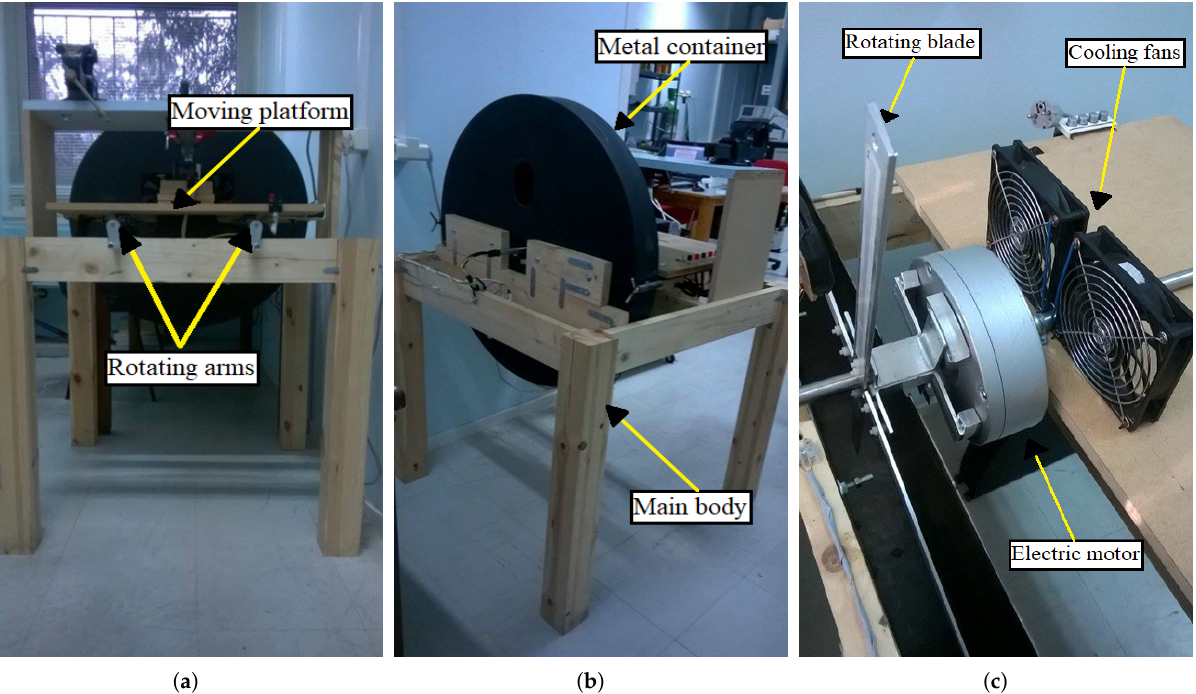
Figure 3. ( a ) Front view of the setup. The moving platform is shifted back and forth on metal rails using two rotating arms. ( b ) Rear view of the setup and the metal container inside of which the mounted, on the motor, blades are rotating, ( c ) View of the electric motor as it is fixed on the moving platform. The blades, mounted on the motor, are also visible inside the half-open metal